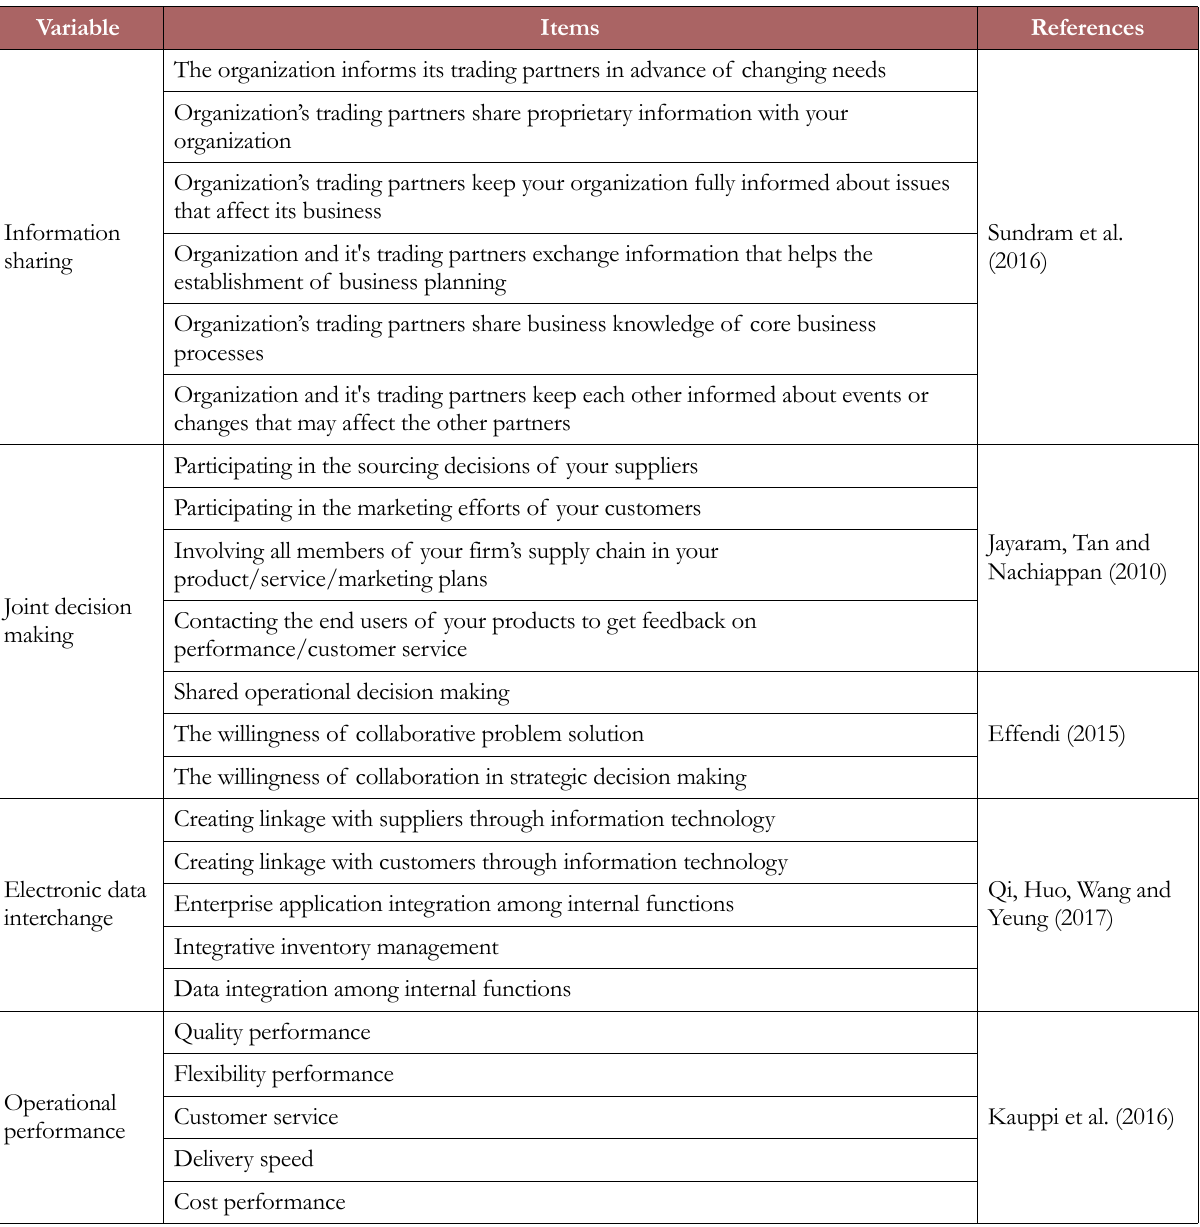
Table 1. Questionnaire items with